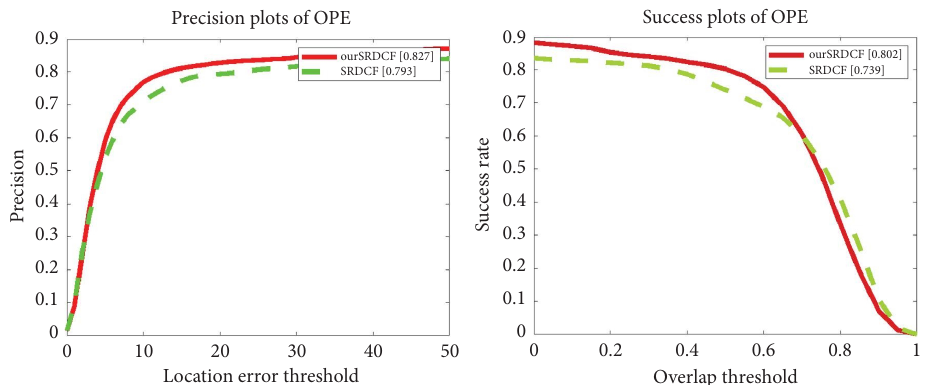
Figure 11: Precision plot and success plot of eight algorithms on the OTB-2013 dataset.